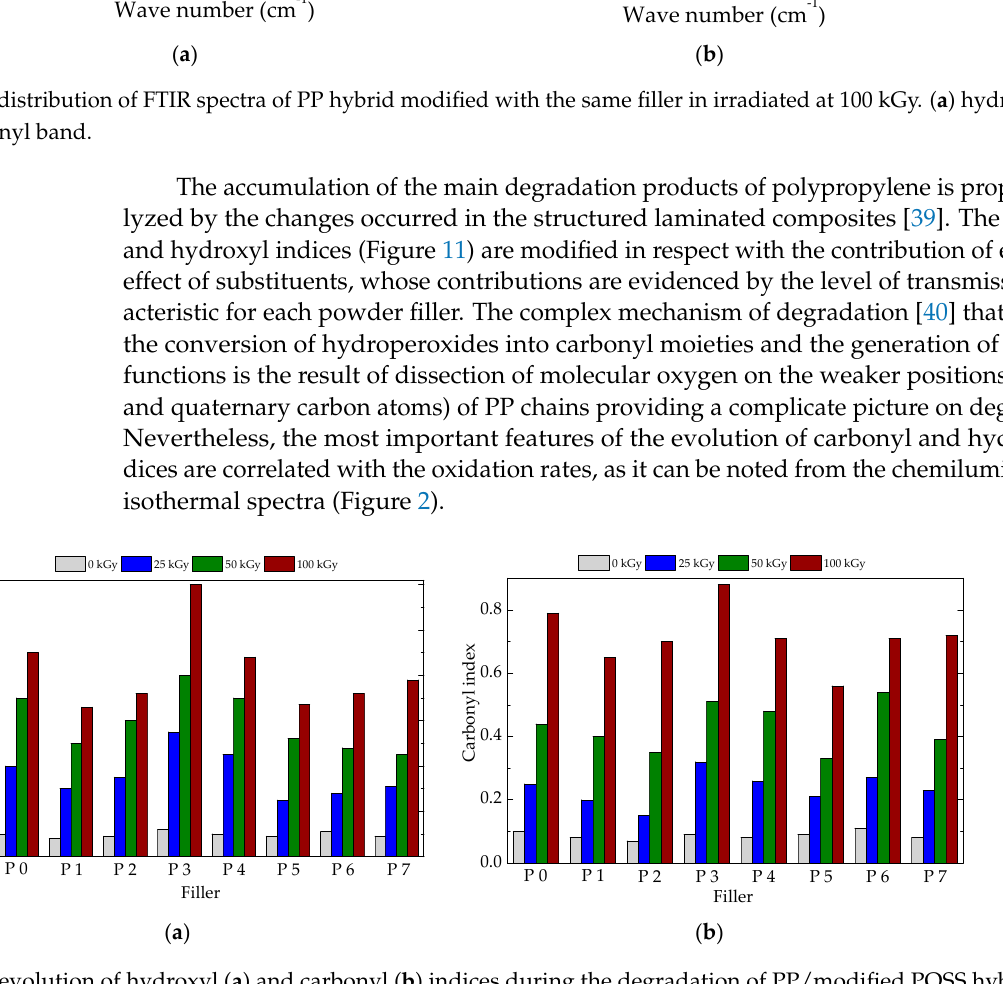
Figure 11. The evolution of hydroxyl ( a ) and carbonyl ( b ) indices during the degradation of PP/modified POSS hybrids exposed to gamma radiation.